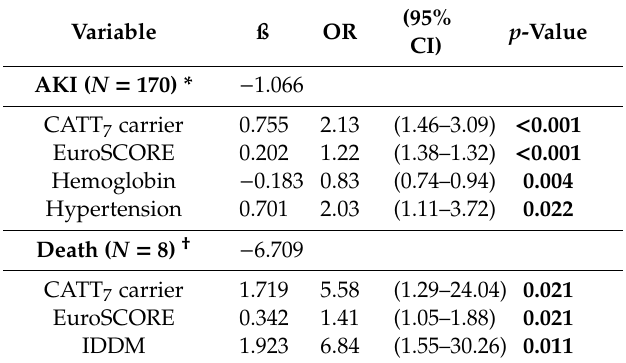
Table 7. Predictors of Acute Kidney Injury (AKI) and death using multivariable logistic regression.